Question: What style of plot is this figure drawn as?
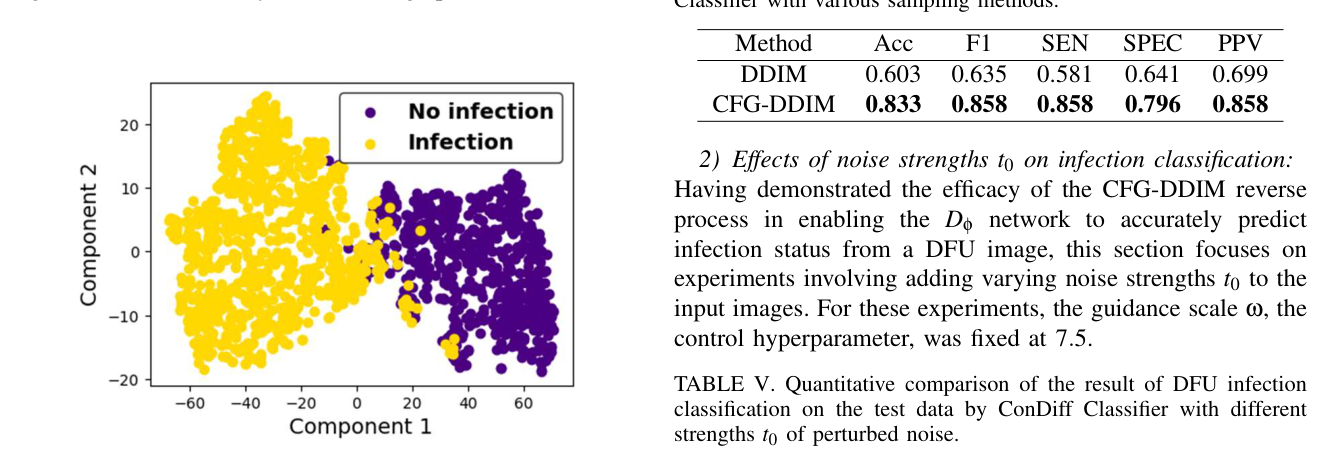
Answer: scatter